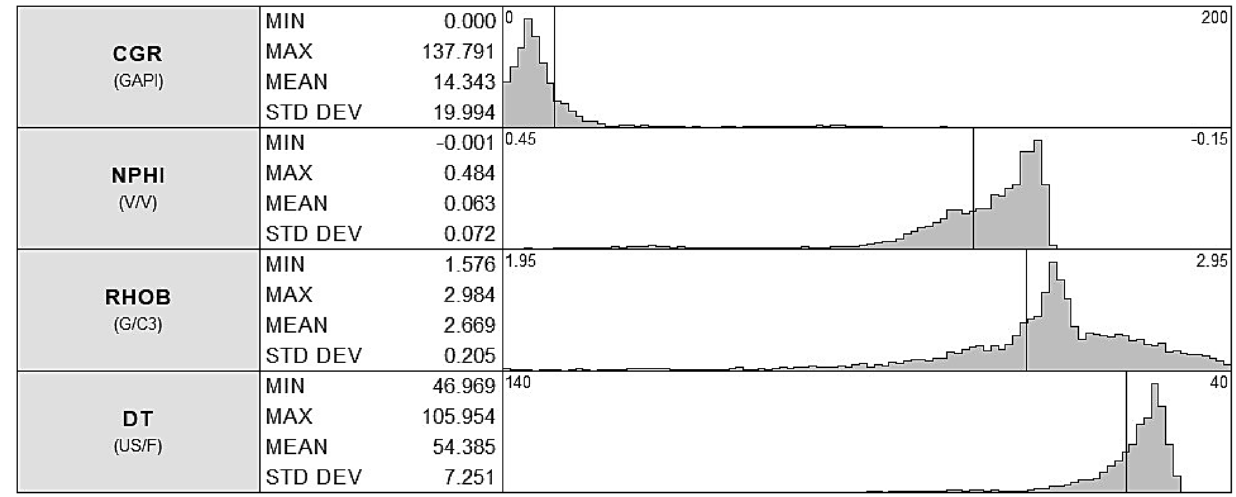
Fig. 5 Frequency of the input logs with minimum, maximum, median, and standard deviation of each input